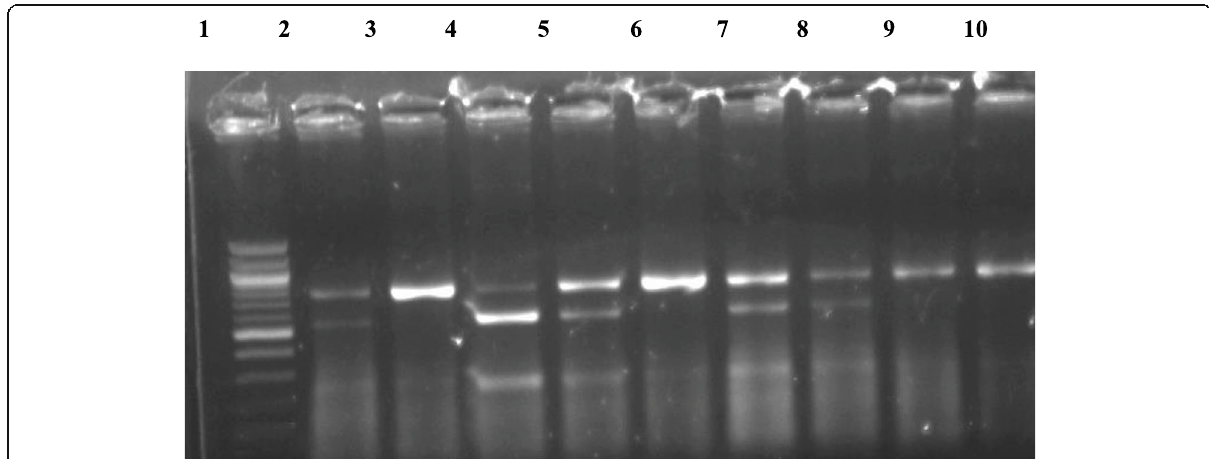
Fig. 2 Gel image of VDR gene ApaI polymorphism PCR-RFLP products. Lane 1: Molecular size marker (100 bp, Vivantis). Lanes 3, 6, 9, 10: AA wild-